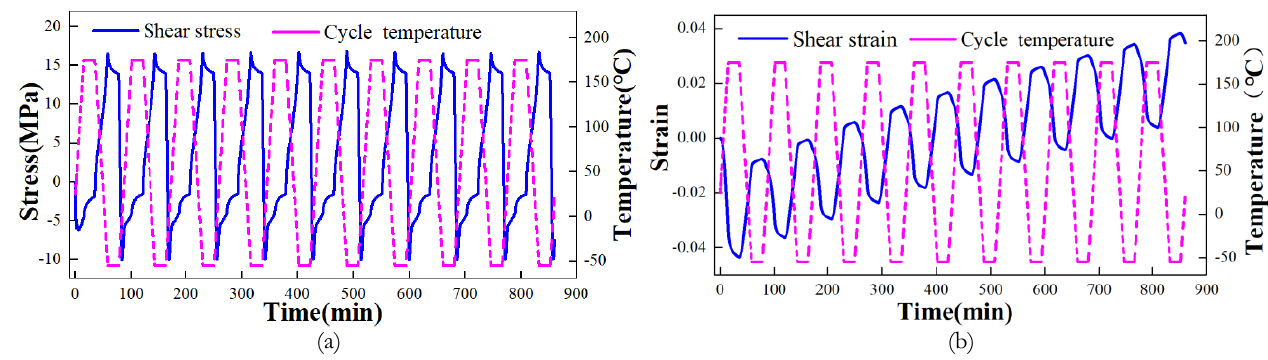
Figure 11: Shear stress-strain of element E2 at TIM2 solder layer: (a) stress, (b) strain. Figs. 9-10 show the distribution of the maximum shear stress and shear strain of TIM1 and TIM2 layers,